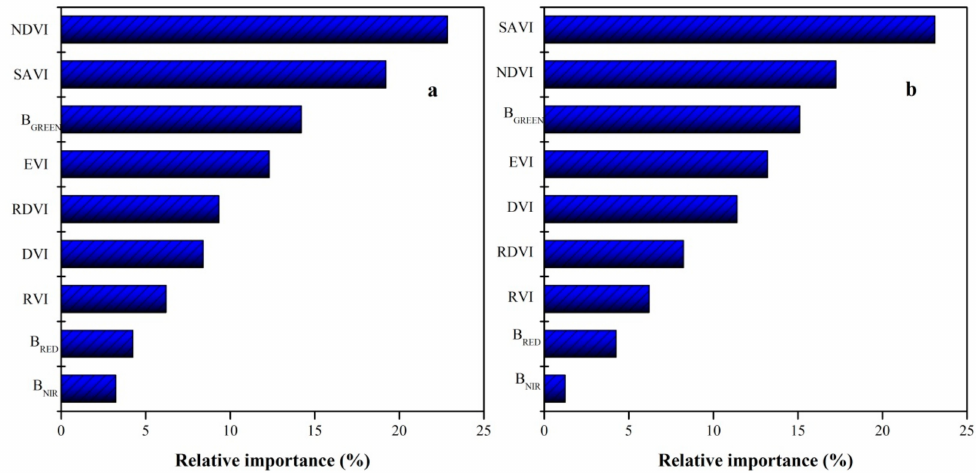
Figure 6. Relative importance of remotely-sensed environment variables as determined from 100 iterations using the boosted regression trees (BRT) in predicting topsoil (0–30 cm) SOC stocks ( a ) and STN stocks ( b ) in 2015, which are combined into percentage. Note: B GREEN , Landsat TM green band reflectance; B RED , Landsat TM red band reflectance; B NIR , Landsat TM near-infrared band reflectance; SAVI, soil adjusted vegetation index; NDVI, normalized di ff erence vegetation index; RVI, ratio vegetation index; DVI, di ff erence vegetation index; EVI, enhanced vegetation index; RDVI, renormalization di ff erence vegetation